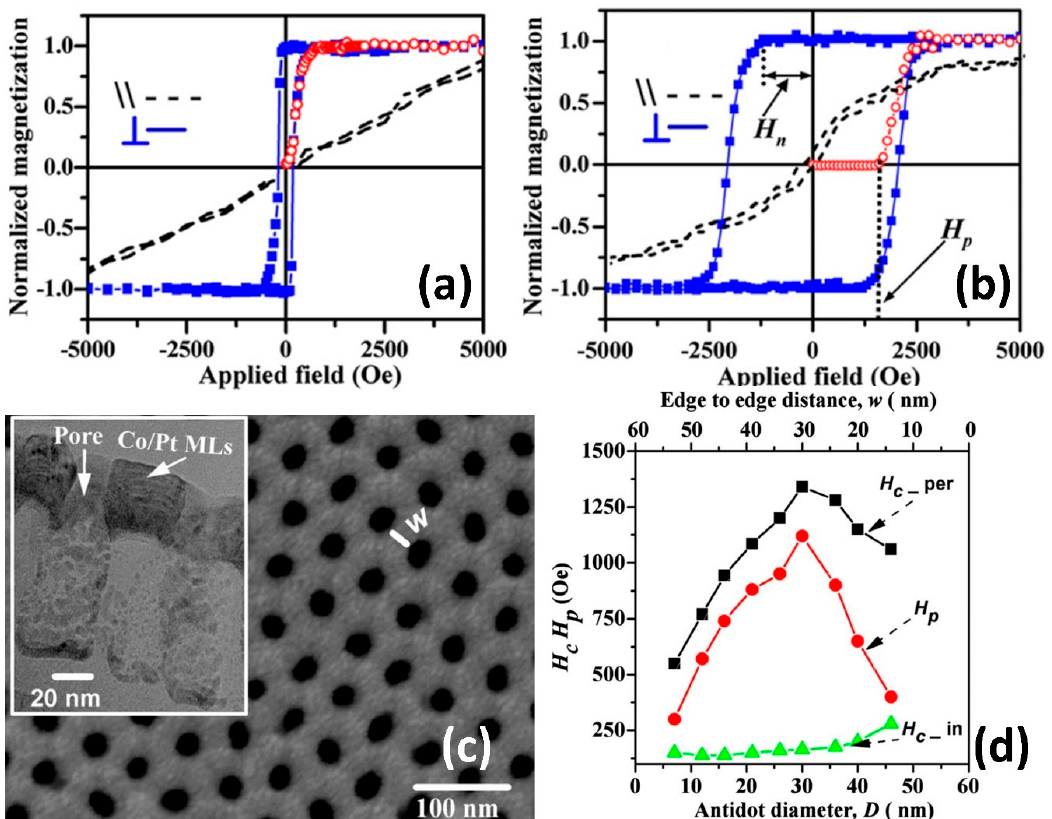
Figure 6. ( a ) Out-of-plane and in-plane hysteresis loop of continuous Co / Pt thin film and ( b ) anti-dot arrays with average pore diameter of 9 nm. Reproduced with permission from Ref. [90], 2008 IOP Publishing; ( c ) SEM image of Co / Pt anti-dot arrays with 25 nm diameter and 35 nm interpore distance. Inset of TEM cross-sectional image and ( d ) magnetization dependence on anti-dot morphology from Ref. [82], 2010 APS Publishing.